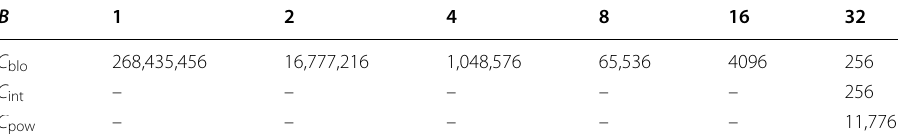
Table 5 Computational complexity for the individual and block subcarrier allocations, the interleaved block subcarrier allocation, and the power combination